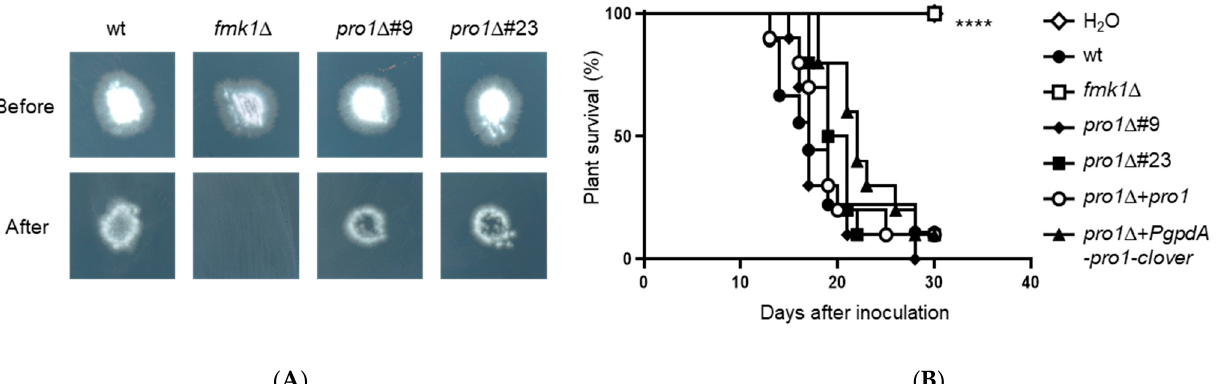
Figure 5. Pro1 is dispensable for invasive hyphal growth and virulence of F. oxysporum on tomato plants. ( A ) Cellophane penetration assay. The indicated strains were spot-inoculated on top of a cellophane membrane on a PDA plate, grown for 3 days at 28 °C and imaged (Before). The cellophane with the fungal colony was removed and plates were incubated for an additional day to determine the presence of mycelial growth on the plate, indicating penetration of the cellophane (After). ( B ) Tomato root infection assay. Kaplan–Meier plot showing survival of groups of 10 tomato plants (cv. Monica) inoculated by dipping roots into a suspension of 5 × 10 6 microconidia/mL of the indicated fungal strains. Percentage survival was plotted for 30 days (****, p < 0.0001). Data shown are from one representative experiment. All experiments were performed at least three times with similar results.